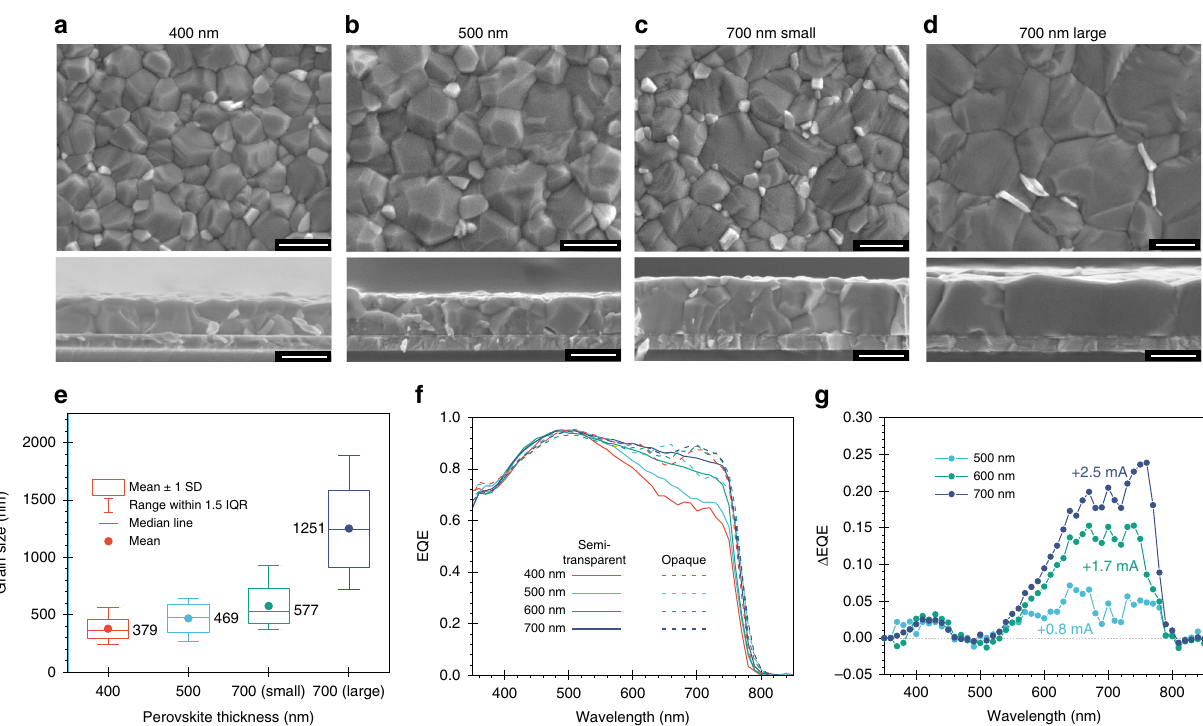
Fig. 3 Effects of perovskite thickness on photon collection. a – d Top and cross-sectional SEM views of perovskite fi lms with different thicknesses ( a 400 nm, b 500 nm, c 700 nm, d 700 nm with larger grains) deposited onto glass/ITO/SnO 2 substrates. e Statistical distribution of grain size obtained by SEM images from a – d fi lms. The scale bar is 500 nm. f Measured EQE spectra of semi-transparent (solid line) and back-mirrored (dashed line) devices with varying perovskite absorber layer thickness. g Difference of EQE spectra between thicker perovskite devices compared to control device with 400 nm